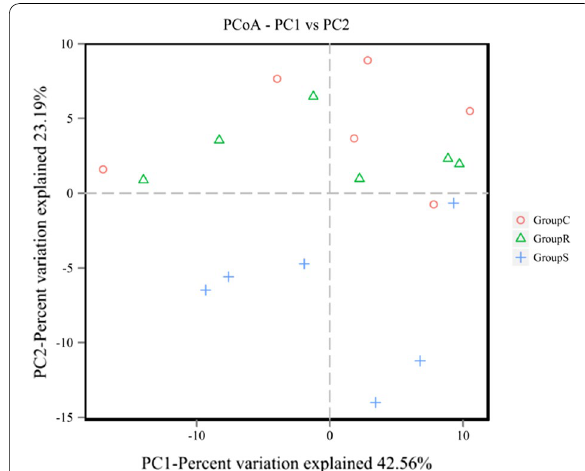
Fig. 2 Principal coordinate analysis (PCoA) of the ruminal bacterial OTUs in different protein source diets. (Group C showed samples in CSM, Group R showed samples in RSM, Group S showed samples in SBM.)